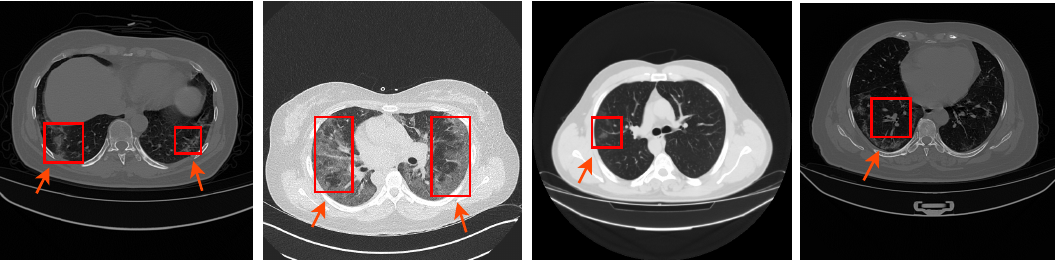
Figure 1. Four examples of COVID-19 existing in chest CT images (COVID-19 infection is highlighted by red